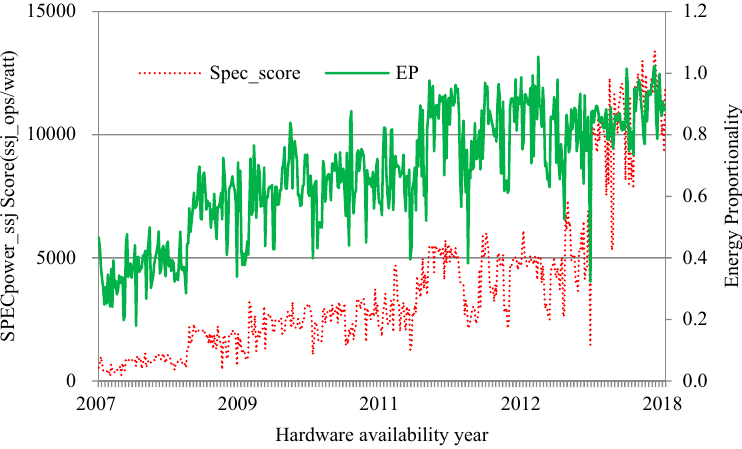
Figure 2. Energy Proportionality (EP) and energy efficiency (EE) trend of commercial servers.